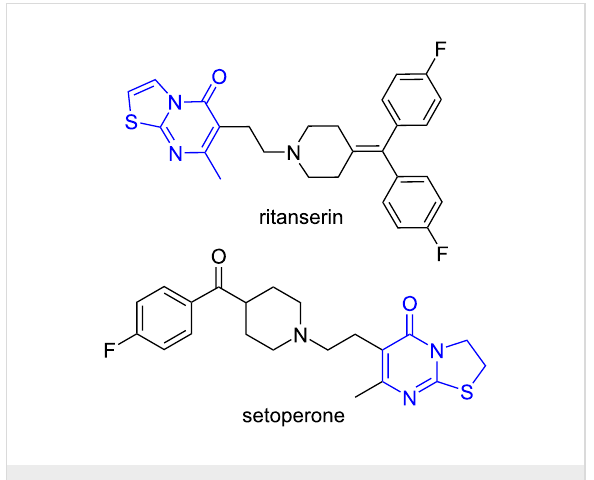
Figure 1: Structure of ritanserin and setoperone drugs.